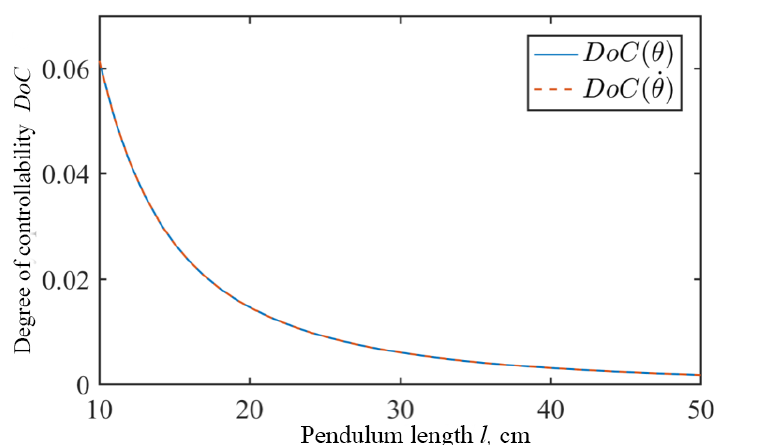
Figure 7. Change in the degree of controllability for θ , ˙ θ when increasing the length of the pendulum l